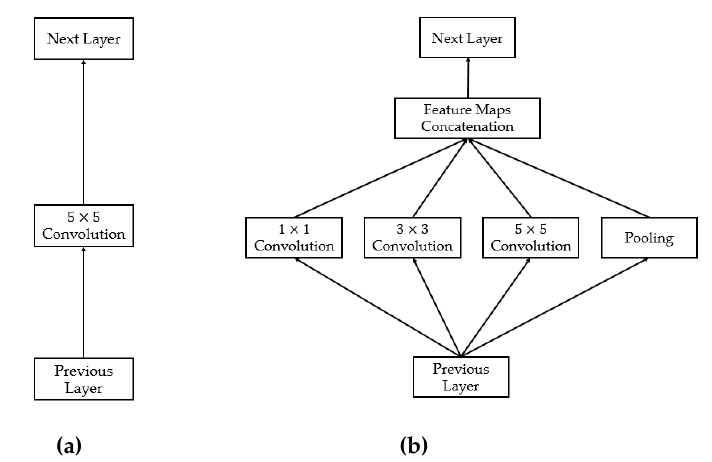
Figure 7. Comparison between: (a) the conventional convolution block versus (b) the naïve inception block.